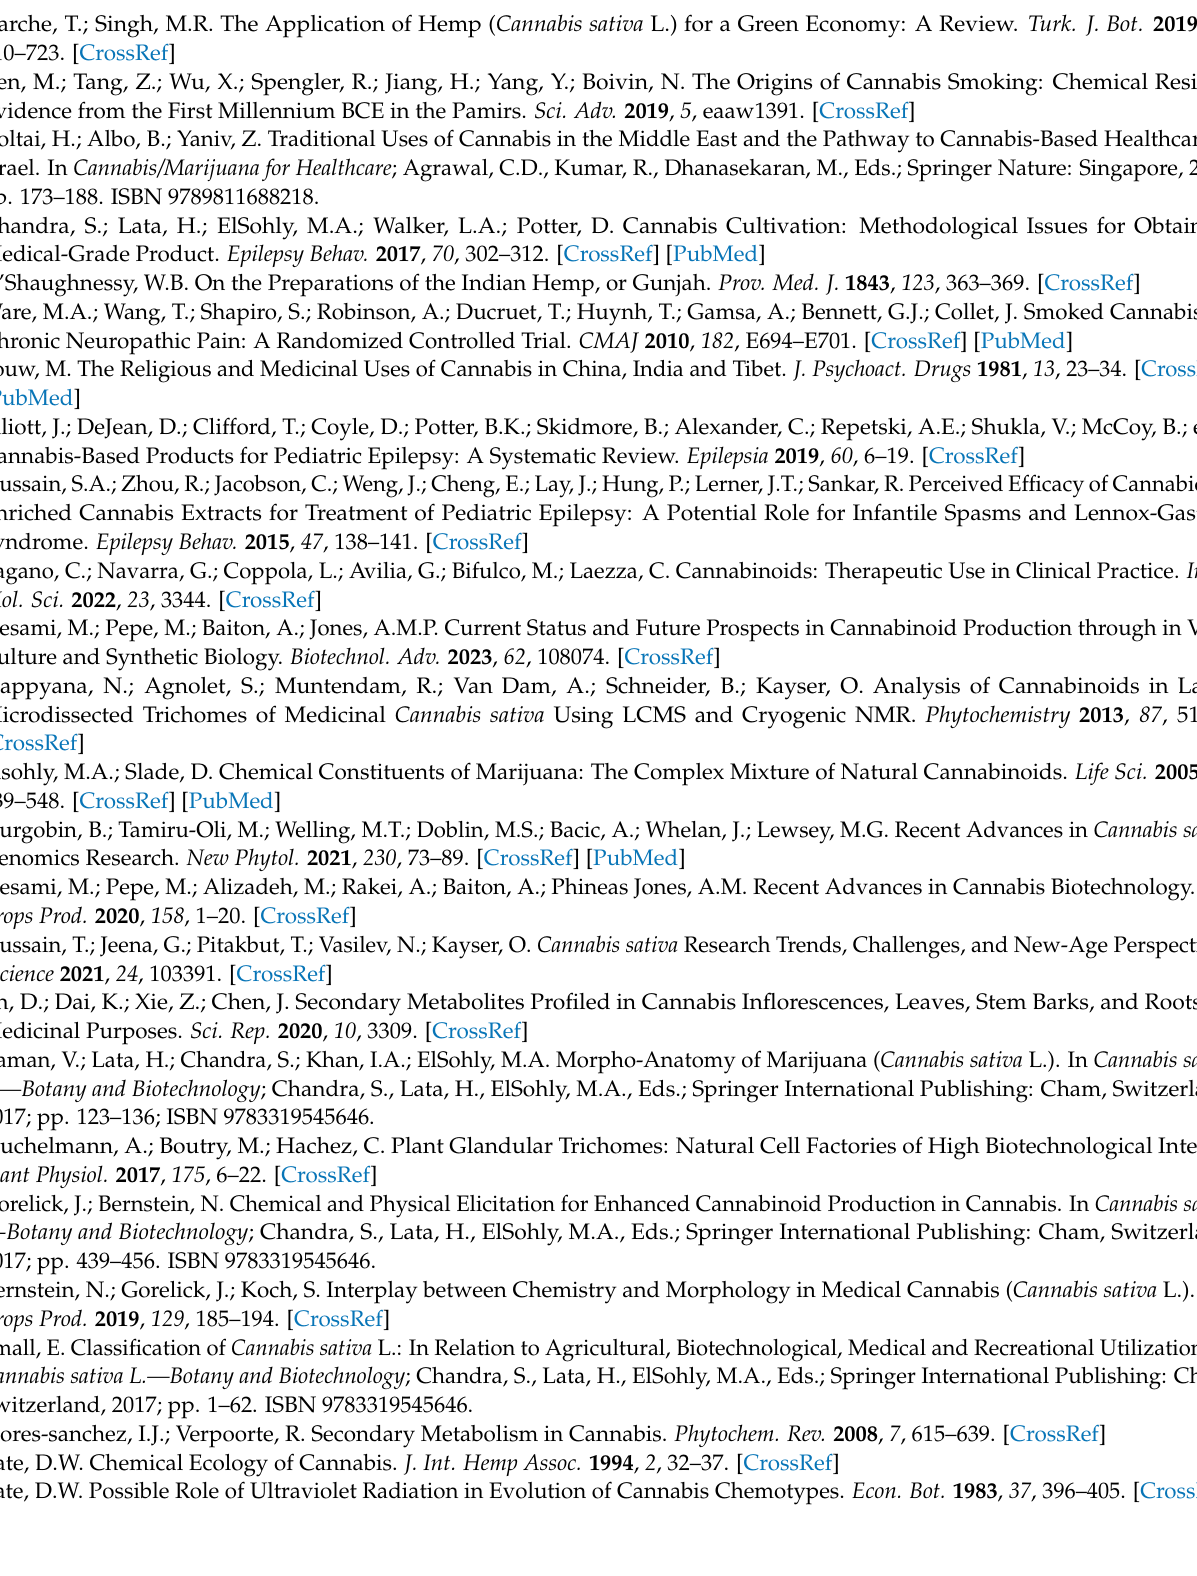
internode length (Int.L), inflorescence number (IN), average inflorescence size (IS), total inflorescence coverage (TIC), inflorescence length (Inf.L), inflorescence width (Inf.W), inflorescence shape (ISH), days to maturation (DTM) and controlled environment